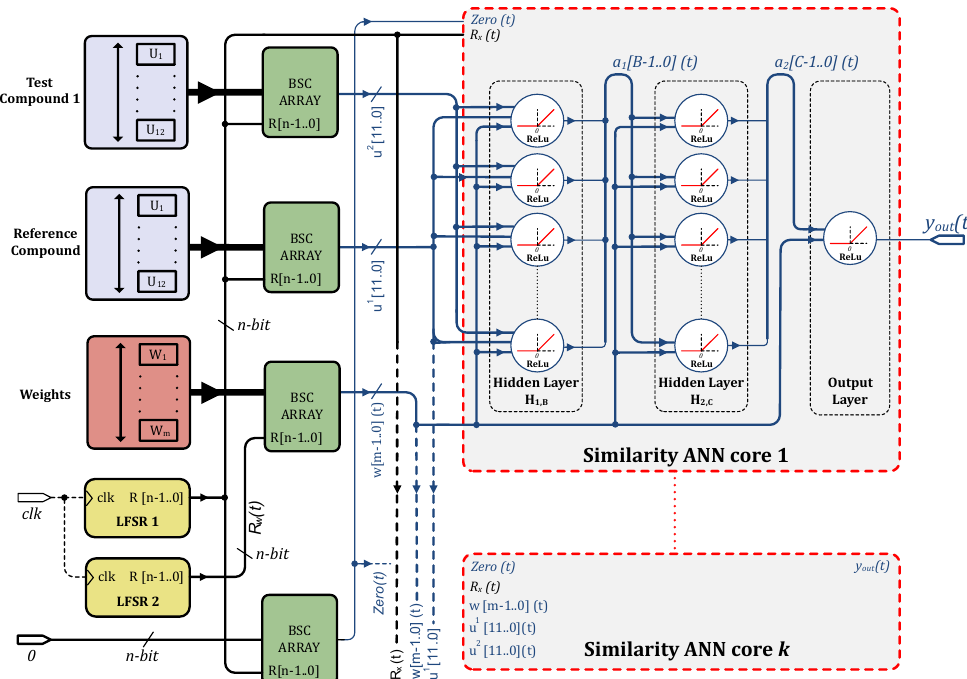
Figure 7. Neural network implementation using two LFSRs for the whole system. LFSR1 is used to generate the input stochastic vector u 1,2 , the zero bipolar signal zero ( t ) and the APC outcome inside each neuron. LFSR2 is used to generate the weight stochastic vector w ( t ) . Shared signals among the k ANN cores are depicted in dashed lines. Signals with n -bit two’s complement are noted in black, whereas stochastic signals are noted in